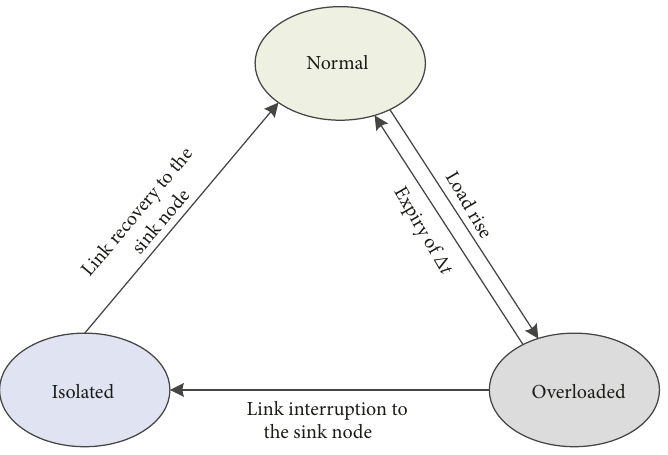
Figure 3: Cascading-state transition of sensor nodes.